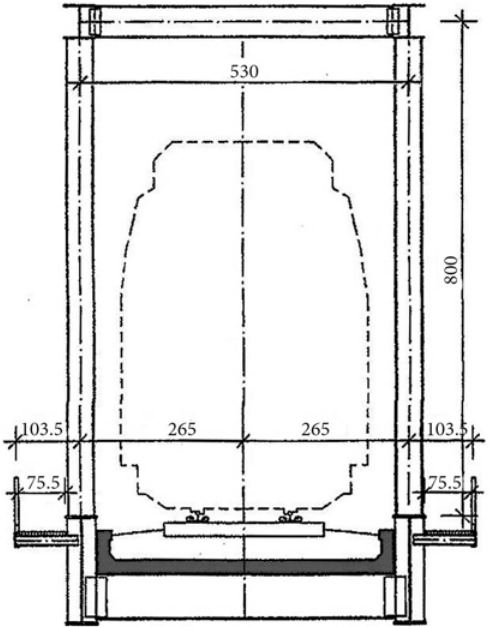
Fig. 1. General view of truss bridge with composite deck